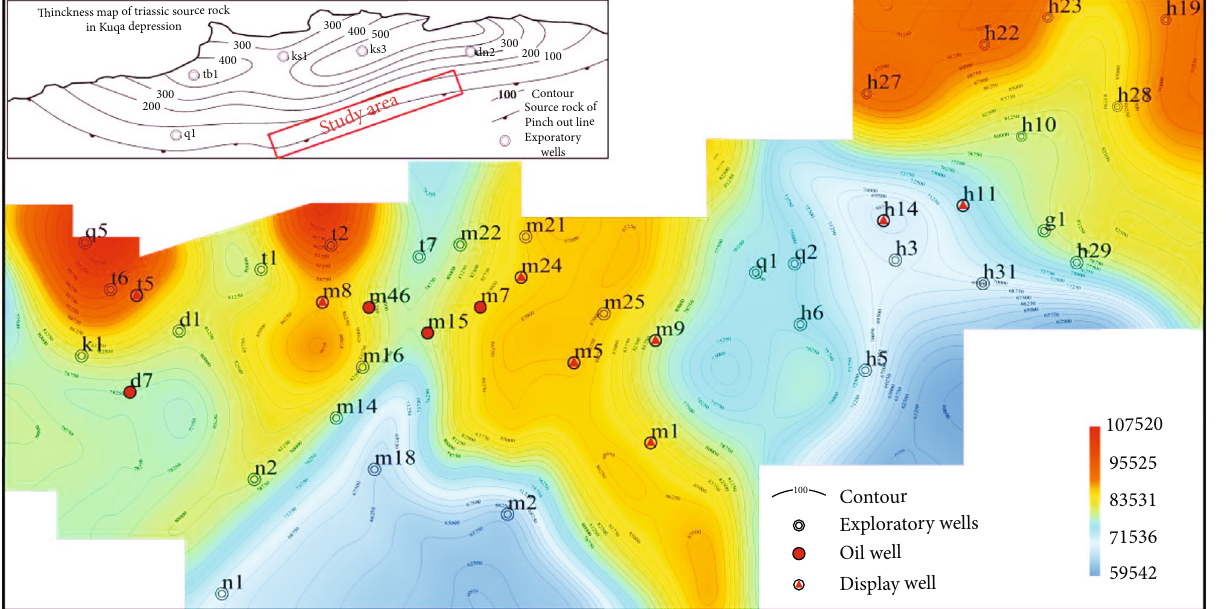
Figure 12: Planar distribution of the Cretaceous paleo fl uid potential during deposition of the Kangcun Formation in the western Tabei